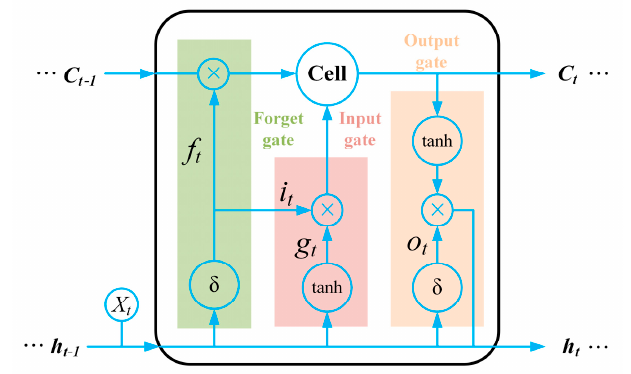
Figure 2. Dataflow of an LSTM cell.